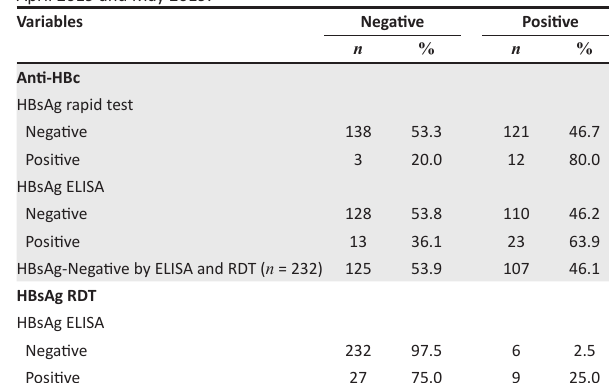
TABLE 3: Patterns of anti-hepatitis B core results for rapid and enzyme-linked immunosorbent assay tests for hepatitis B surface antigen and relationship